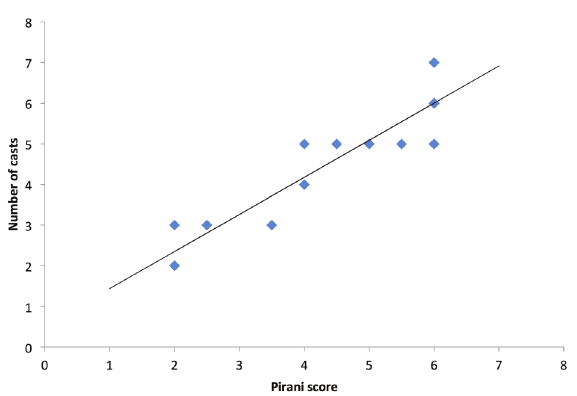
Association between Pirani score and number of casts. Fig. 3: